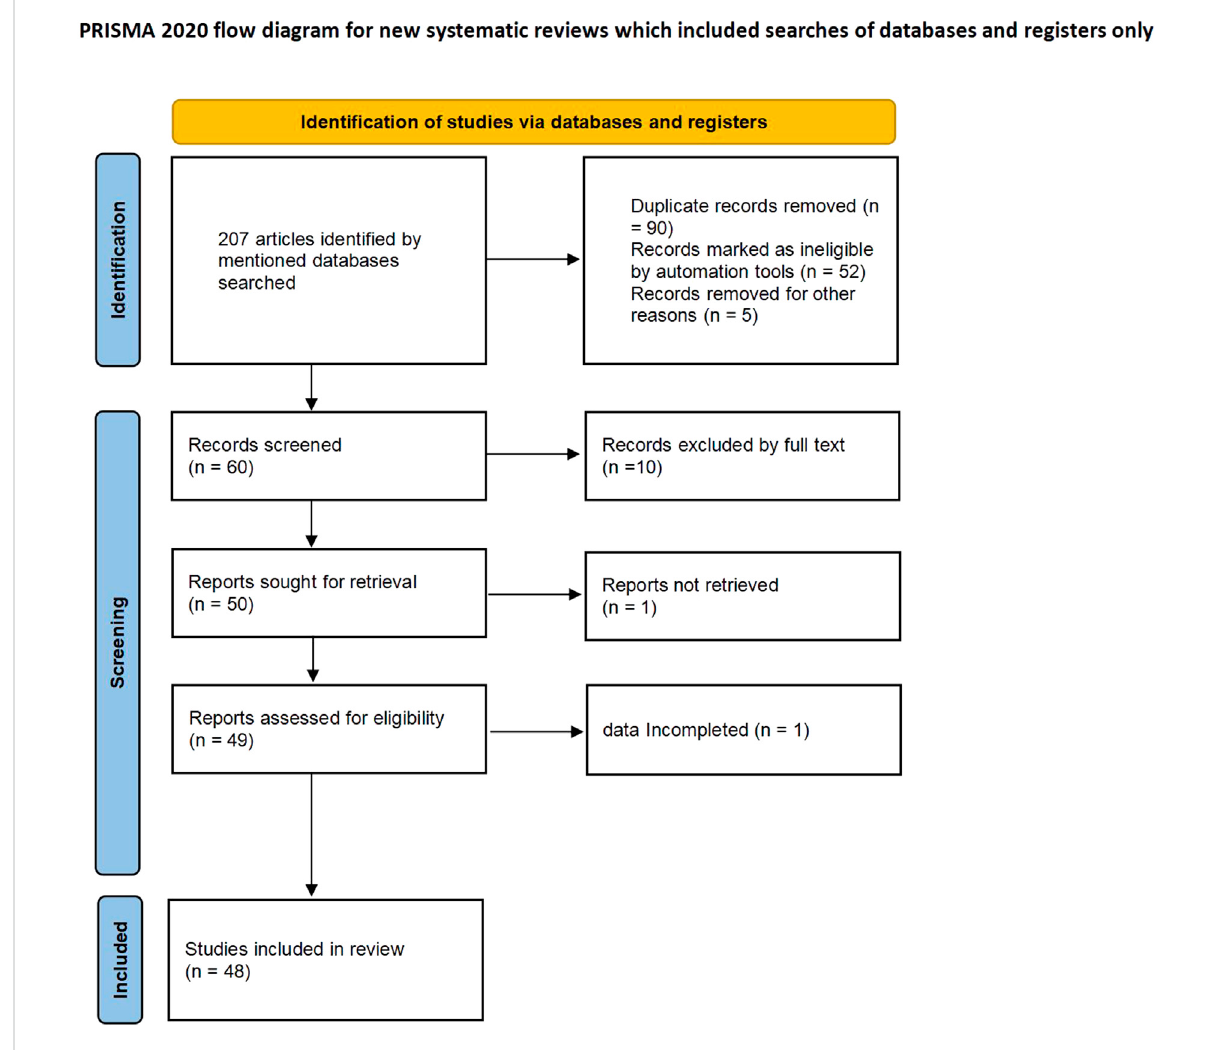
FIGURE 1 Flow diagram for searching studies in the current